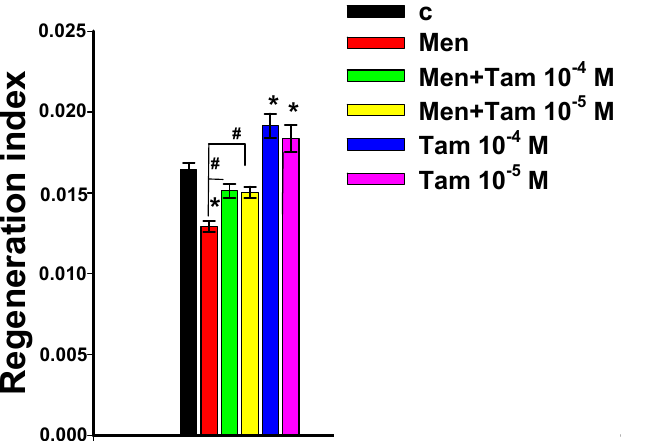
Figure 5. Antioxidant effects of Tameron on regenerating planarians in non-treated animals and after menadione-induced oxidative stress. c—non-irradiated control, Tam—Tameron, Men—menadione. * p < 0.001 (difference from control), # p < 0.001 (difference from irradiated group without Tameron treatment). Data are presented as mean ± SD.